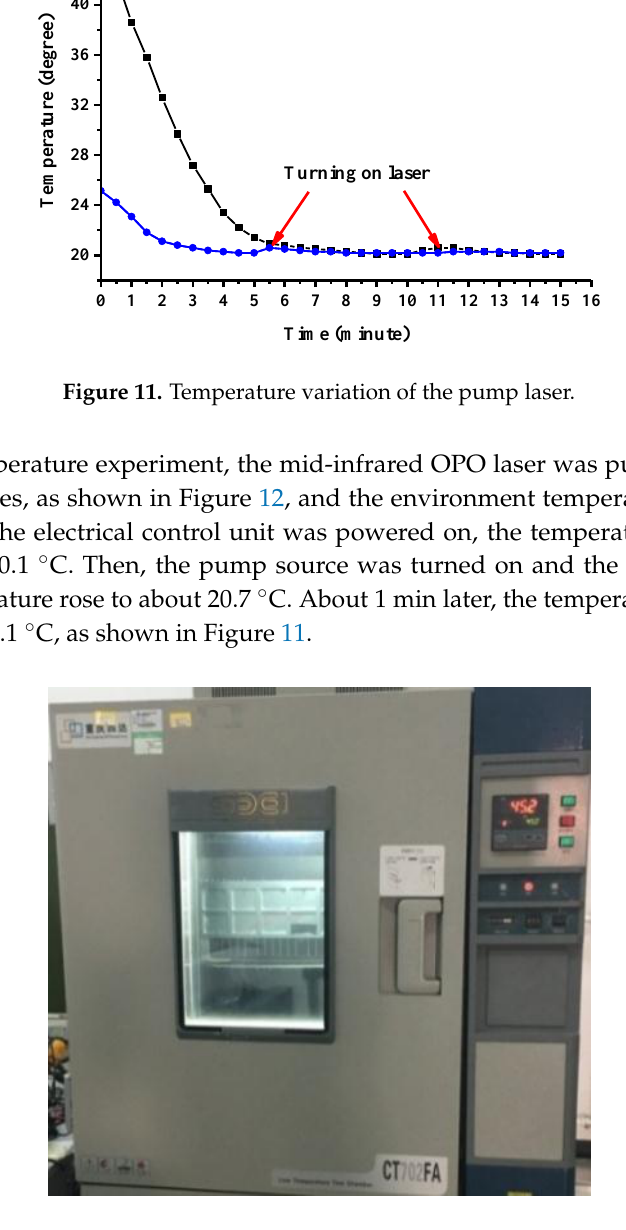
Figure 12. Experiment in the high temperature environment.